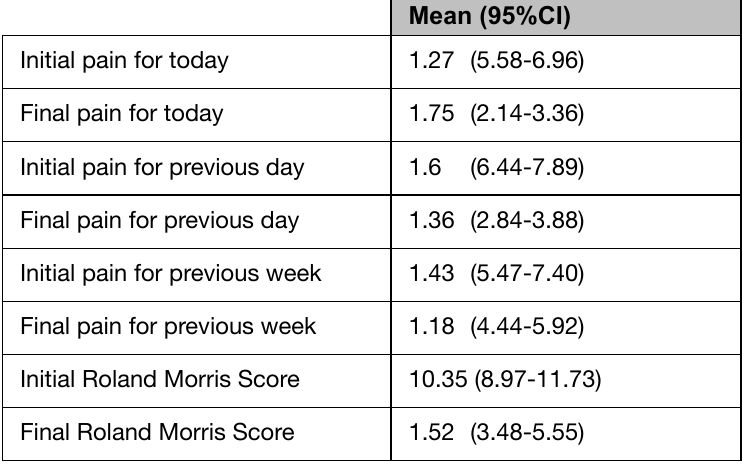
Table 2: Description of mean pain and disability (n=48)